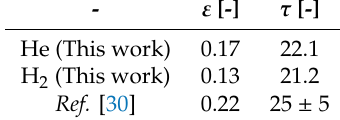
Table 8. Values of porosity, ε , obtained from the structural properties of the amorphous silica model and the adjusted tortuosity, τ , by the solid vibration (SV) model .